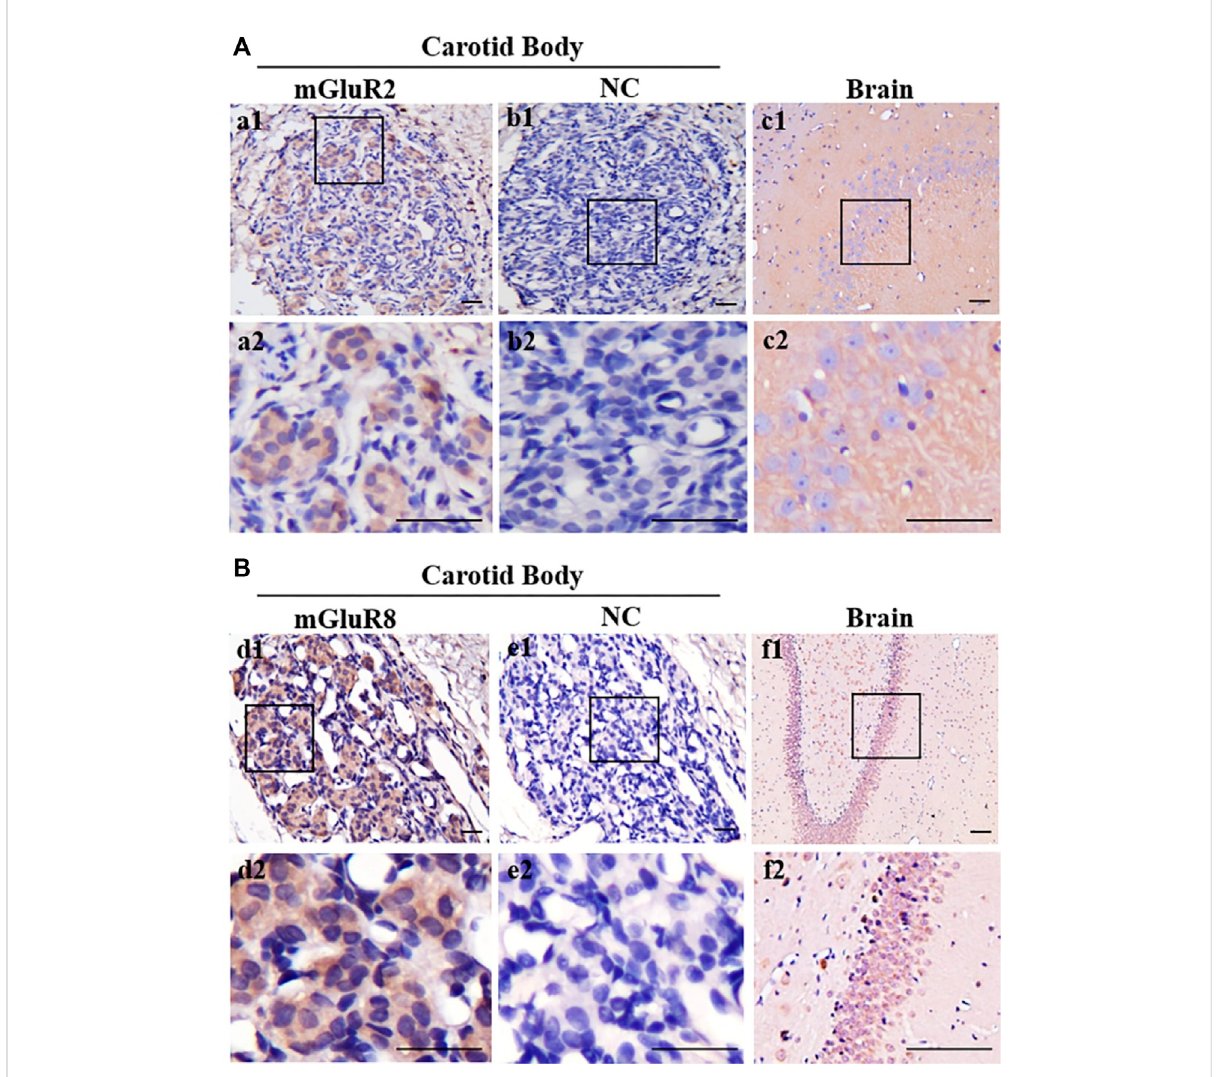
FIGURE 2 Immunohistochemical staining of mGluR2 and mGluR8 in rat CB. The representative images of rat CB and brain sections were immunostained with mGluR2 (A) and mGluR8 (B) . The brown staining represents the mGluR2 (Figure a1) or mGluR8 (Figure d1), while the blue staining represents hematoxylin-stainedcellnuclei.Figureb1ande1arenegativestainingcontrolsobtainedbyomittingtheprimaryantibody.Figurec1-2andf1-2ofrat brain hippocampus area are individually positive controls for mGluR2 and mGluR8. Figure a2-f2 are higher magni fi cation images of framed areas in a1-f1, respectively. mGluR: glutamate metabotropic receptor; NC: negative control. Scale bar = 50 μ m for all